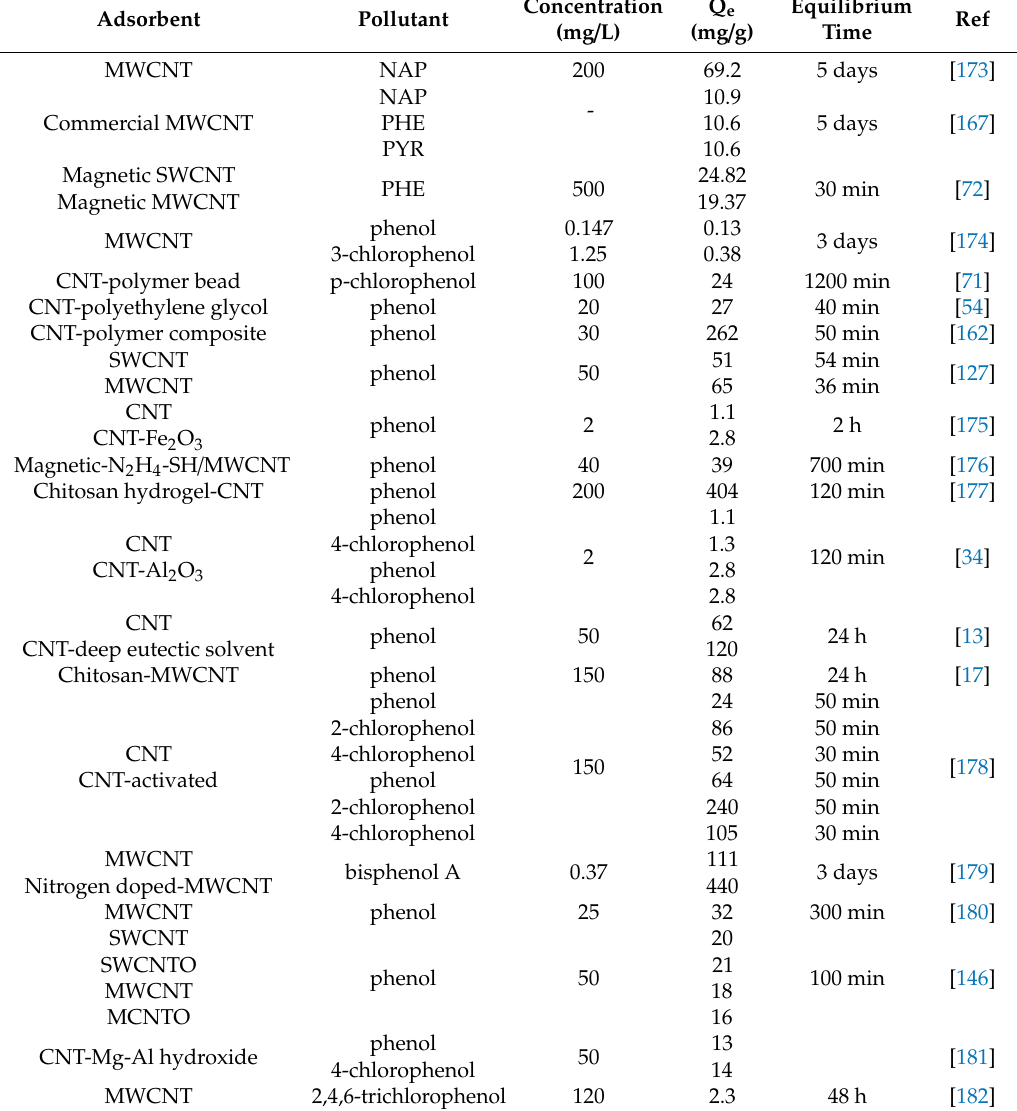
Figure 6. Schematic diagram for the mechanism of phenol adsorption onto carbon nanotubes (CNT). Reproduced from ref [146]. Table 7. Adsorptions of PAHs and phenols onto CNTs and their composites .